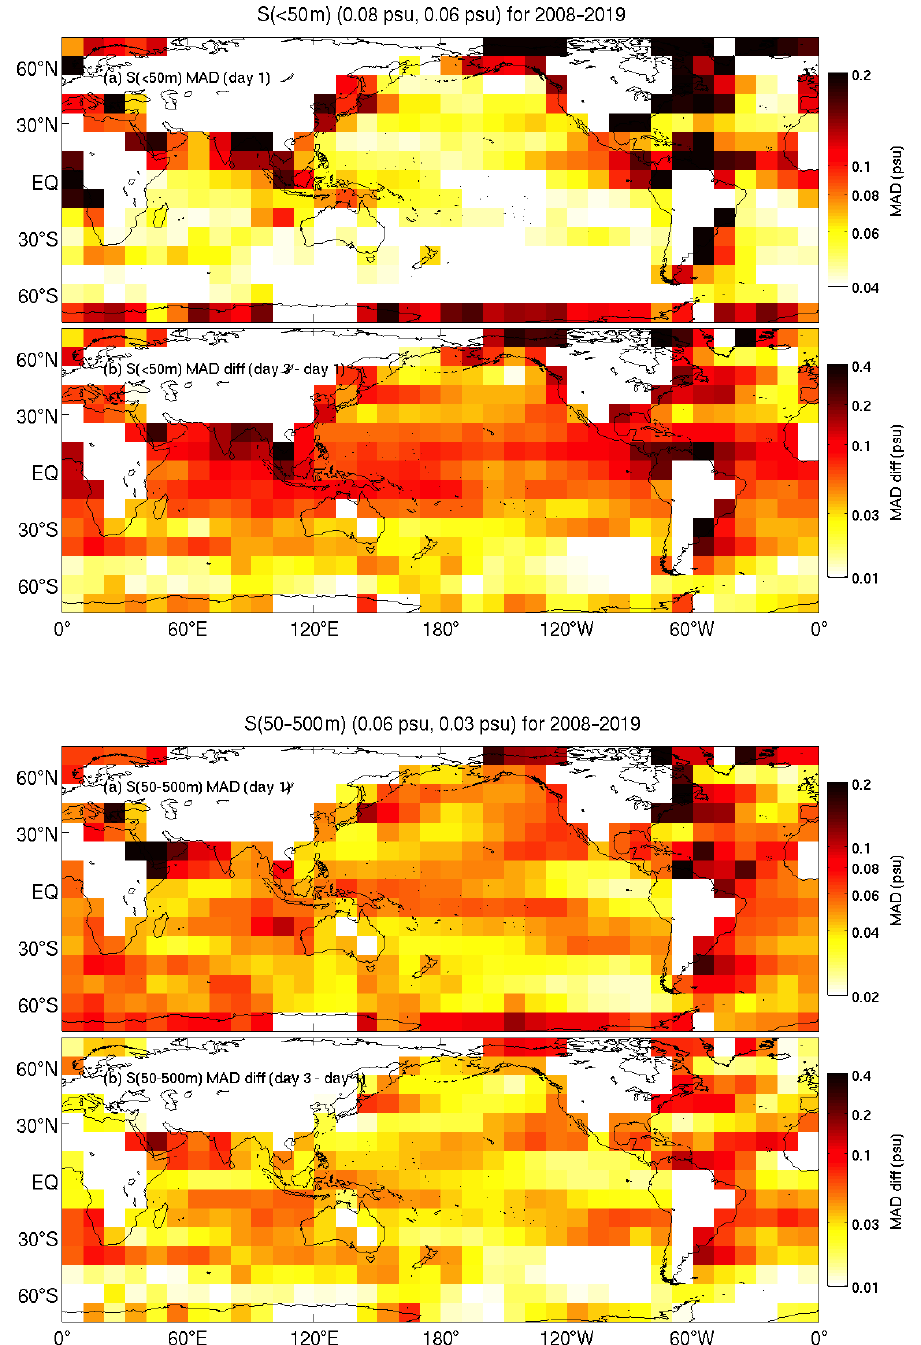
Figure 6. Binned mean absolute deviations of salinity between 0 and 50m (top pair) and 50 and 500m (bottom pair), averaged over 2008– 2019 from the first day (top) and day 3 minus day 1